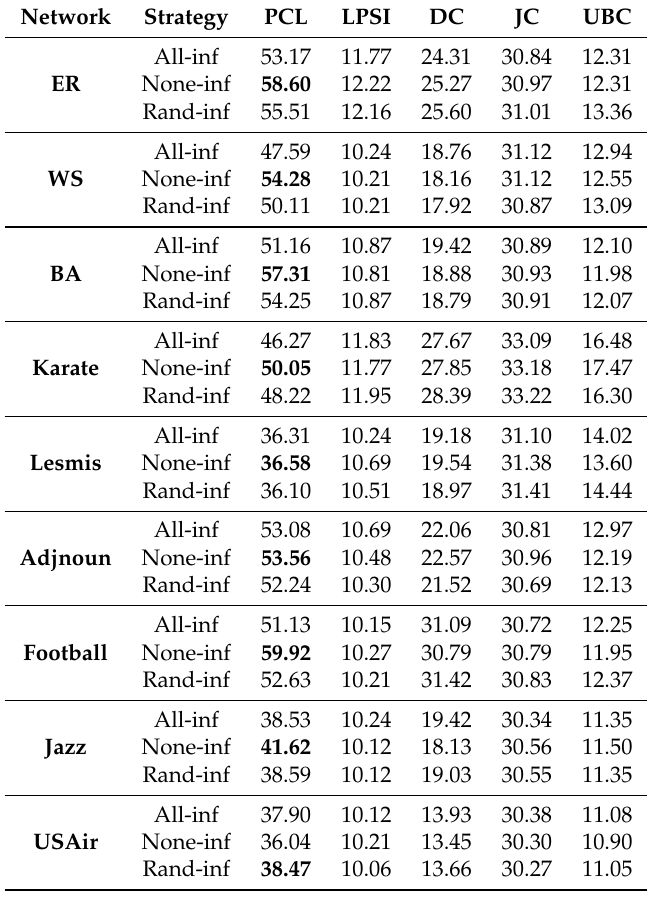
Table 2. The average precision (PCL vs. LPSI vs. DC vs. JC vs. UBC), α = 0.1 : 0.1 : 1, β = − 1, for different strategies of dealing with unknown infection information in synthetic networks and real networks with 20% uncertainty. The number of sources is s = 3 in all networks, < k > = 4, N = 100 in ER, WS and BA network, the connect probability is 0.1 in WS network. Besides, a bold number denotes the highest accuracy of sources localization in each